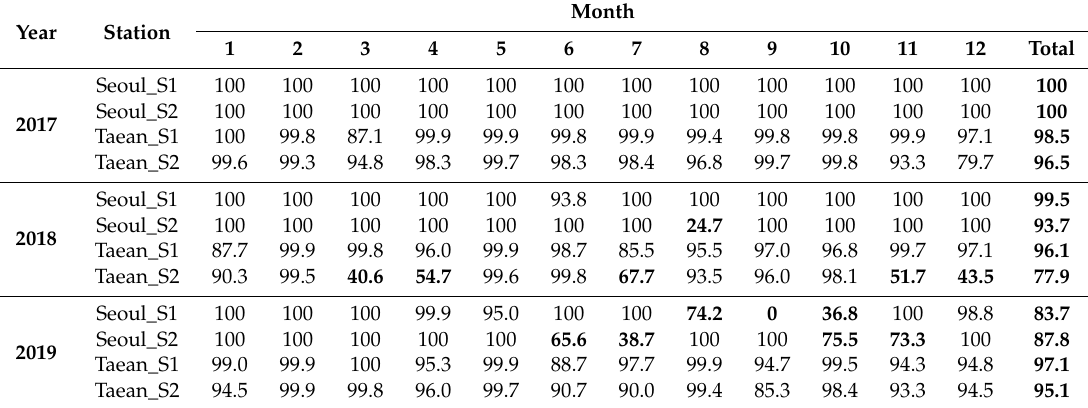
Table 2. Monthly data availability at each station. Data availability rates of less than 80% are shown in